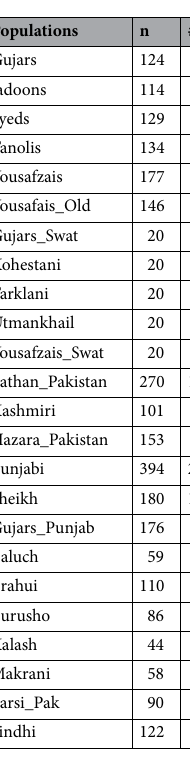
Table 3. Summary statistics for KPP ethnic groups and other Pakistani populations based on Y-STR haplotypes. n = number of samples; # = number of haplotypes; HD: Haplotype Diversity; PD: Pairwise differences; Citations and references for the comparative populations are provided in Table